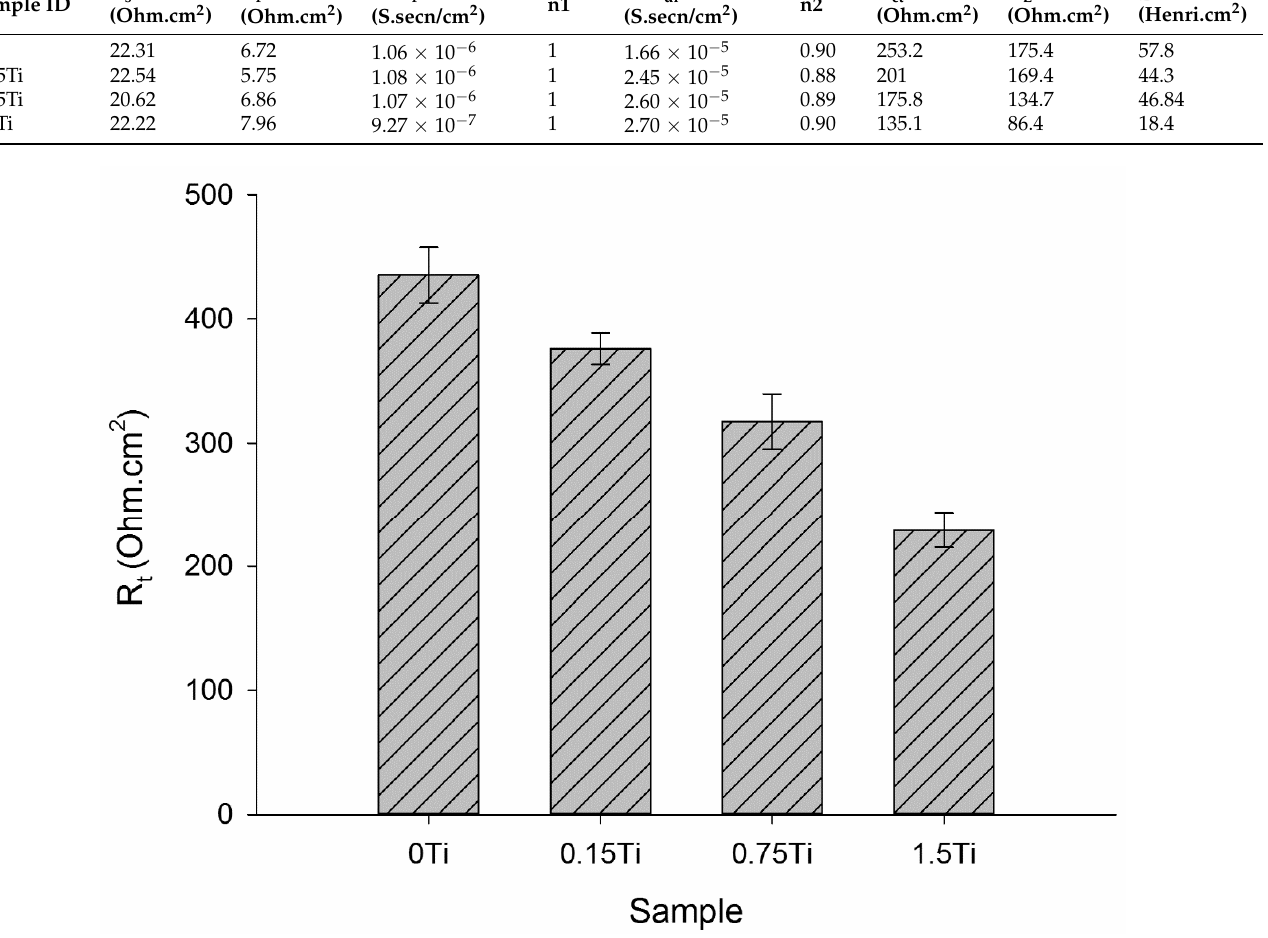
Figure 12. The total resistance values of the